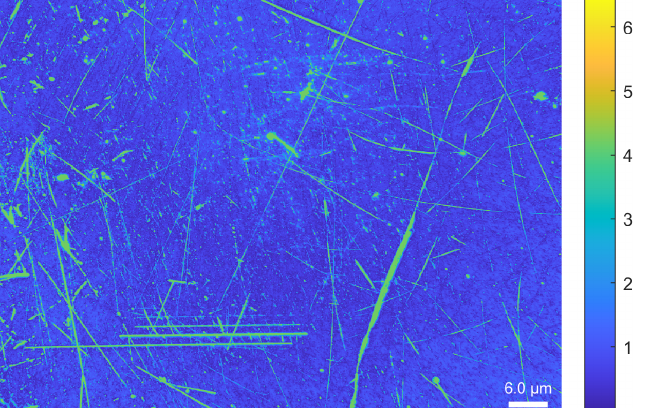
Figure 8. Multi-level saliency map estimated with the statistics descriptors calculated from an RTI acquisition of the watch dial: Saliency map multi-level SP 100% , SP 99.9% , SP 99.5% , SP 99%